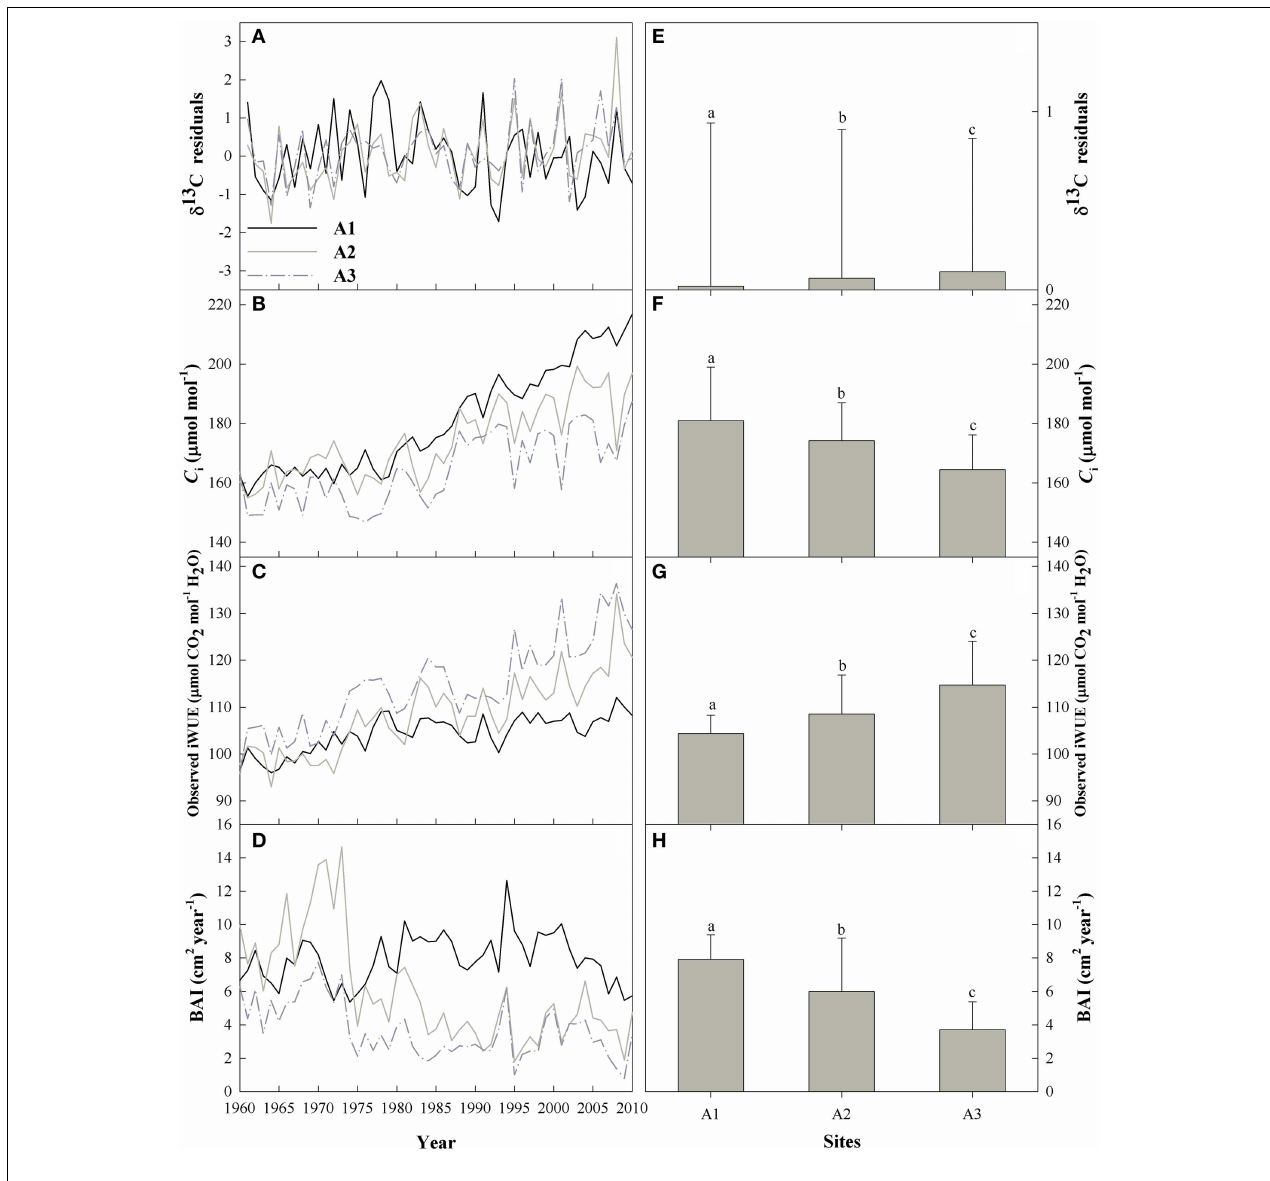
FIGURE 3 | Left: the temporal trends of (A) the δ 13 C residuals chronology, (B) the intercellular CO 2 concentration ( C i ), (C) the intrinsic water-use efficiency (iWUE), and (D) the basal area increment (BAI) for the three sites from 1960 to 2010. Right: the means